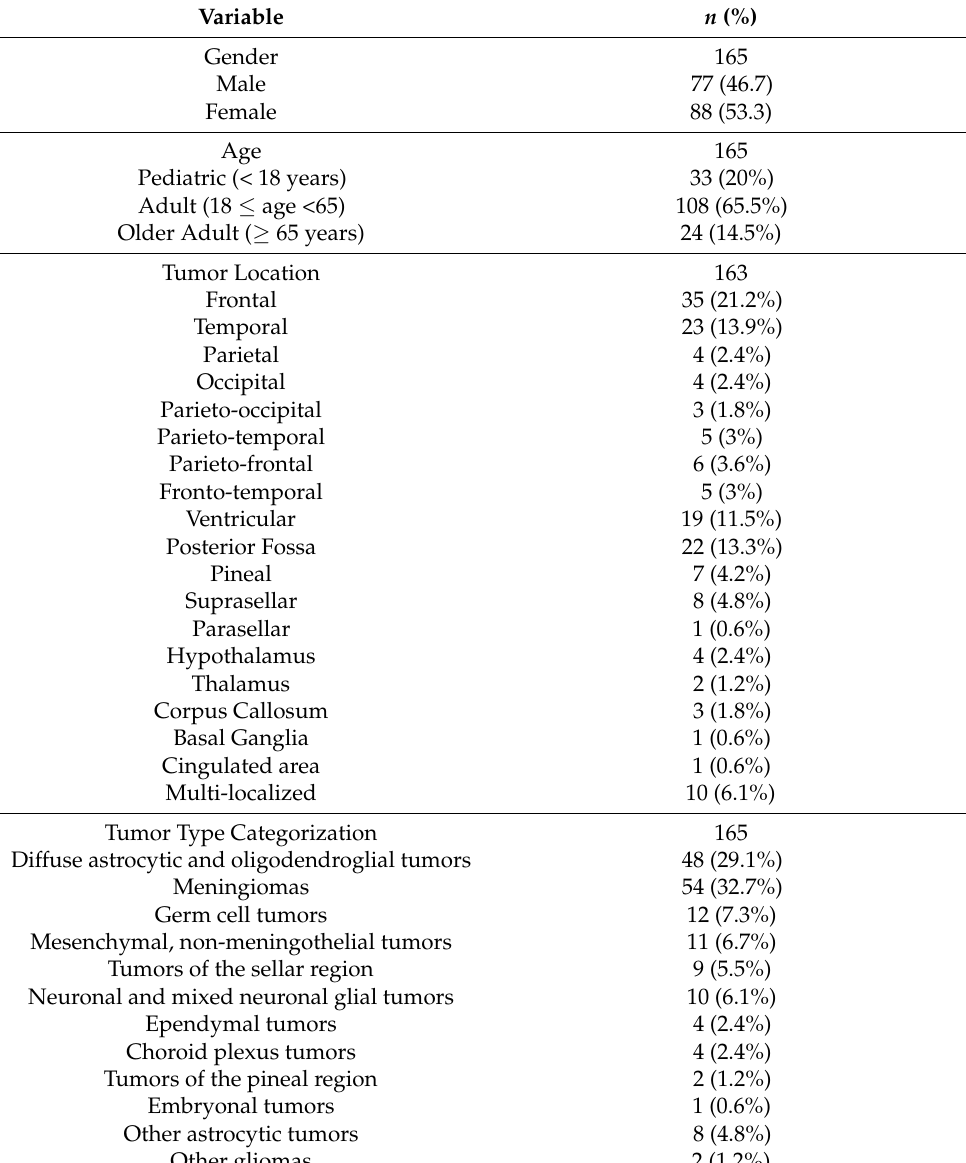
Table 1. Clinical characteristics of 165 brain tumor cases with psychiatric